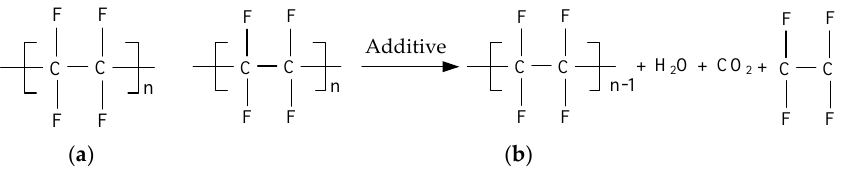
Figure 7. PTFE depolymerization reaction. ( a ) Chemical structure of the PTFE; and ( b ) thermal degradation.